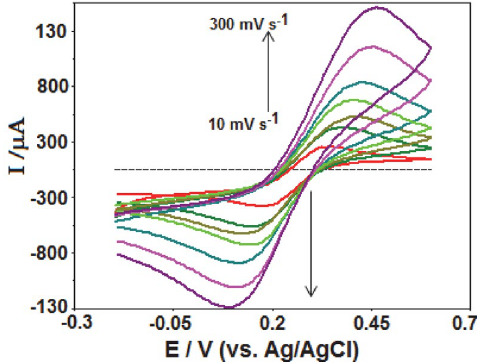
Figure 2. Electroactive surface area of PGE evaluated using cyclic voltammetry. Scan rate; 10–300 mV s –1 .